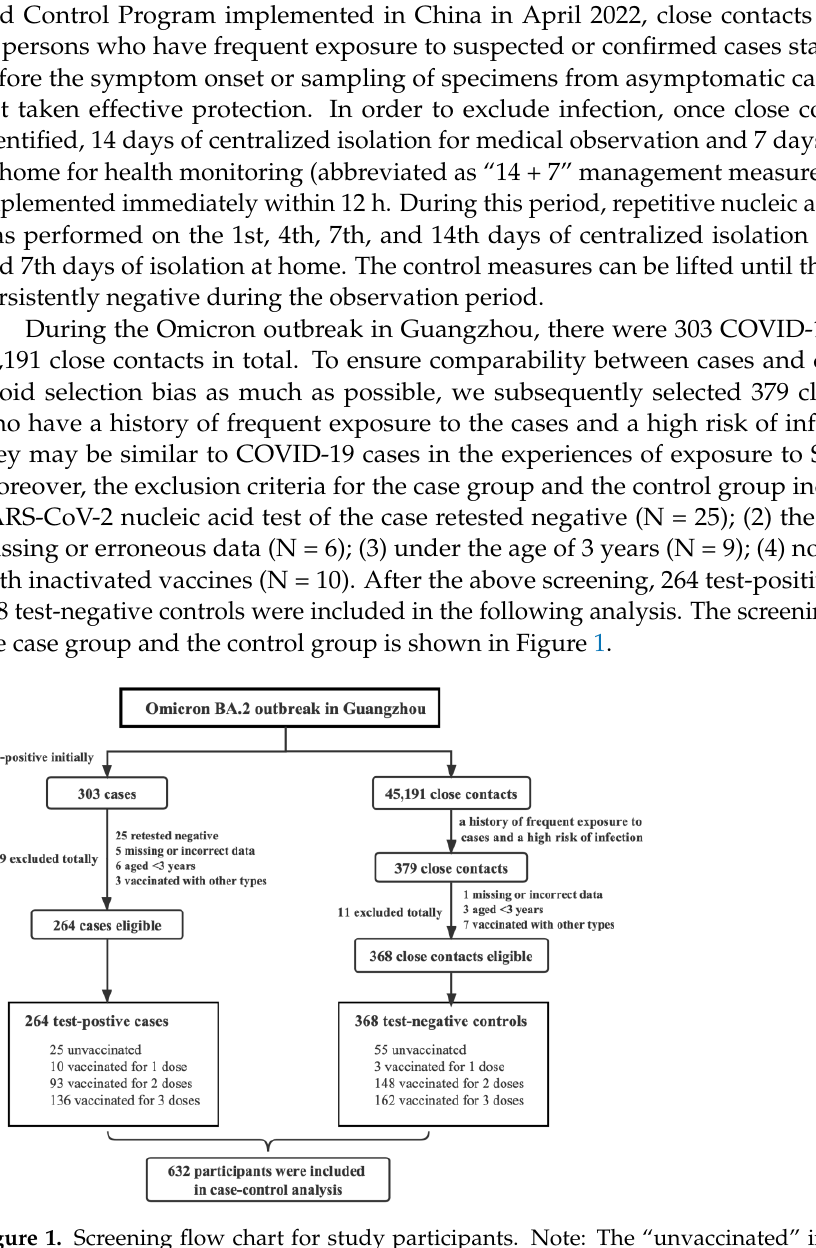
Figure 1. Screening flow chart for study participants. Note: The “unvaccinated” includes those who received their first dose of vaccine less than 14 days prior to infection (N = 2) or last exposure (N = 3), besides those who had never received the COVID-19 vaccine before. The “other types” refer to recombinant subunit vaccine and adenovirus